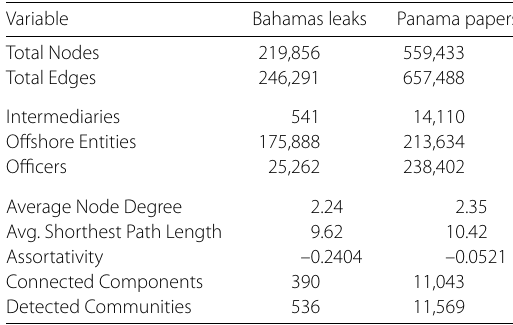
Table 2 Some Network